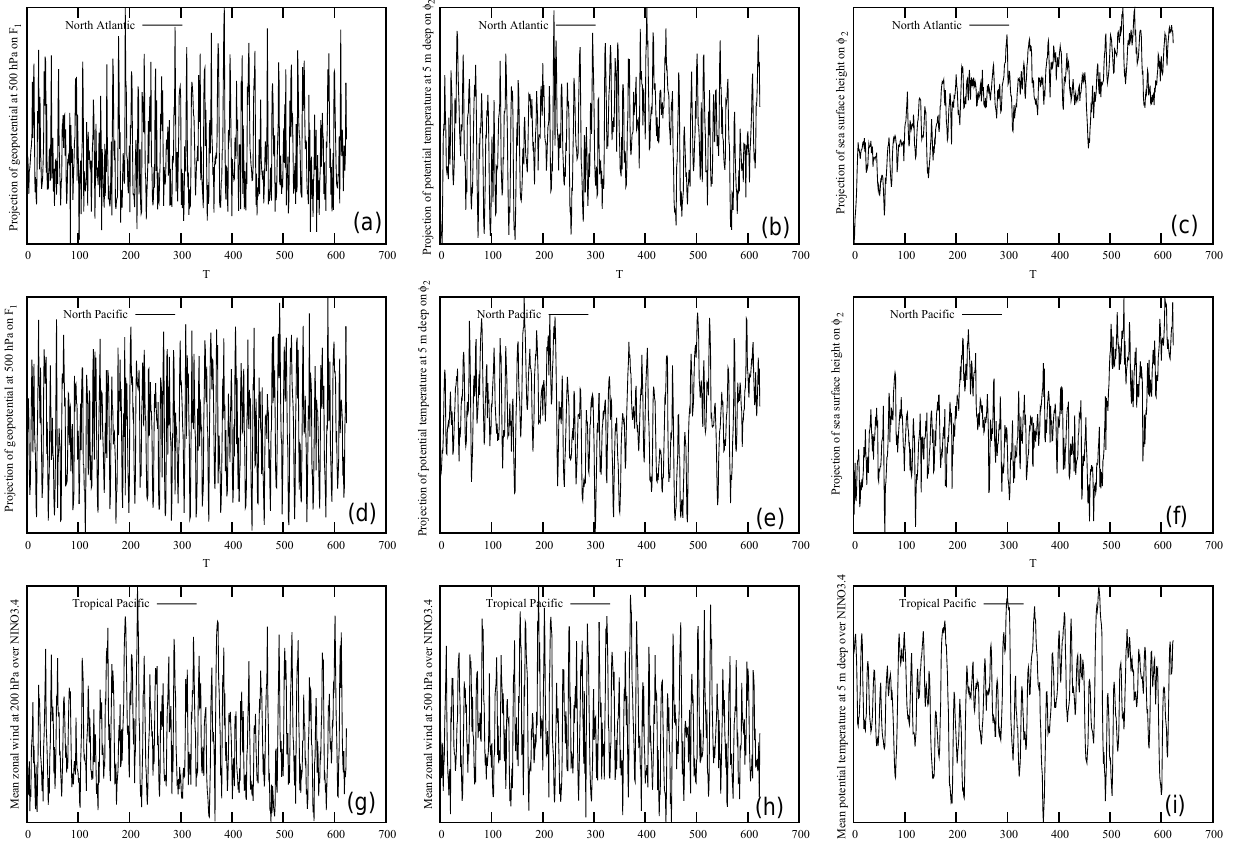
Figure 1. Monthly-averaged time series of the projections of the Atlantic, Pacific and tropical fields on the dominant modes of the dynamics, as obtained from the ORA-20C ocean reanalysis and the ERA-20C atmosphere reanalysis. (a–c) The geopotential at 500hPa projected on F 1 , the ocean potential temperature at 5m deep projected on φ 2 and the sea surface height projected on φ 2 for the Atlantic. (d–f) As for the top row but for the Pacific. (g–i) Zonal velocity at 200 and 500hPa, and the ocean potential temperature at 5m deep averaged over the Nino3.4 region. All time series are standardized (with a mean equal to 0 and a variance equal to 1).